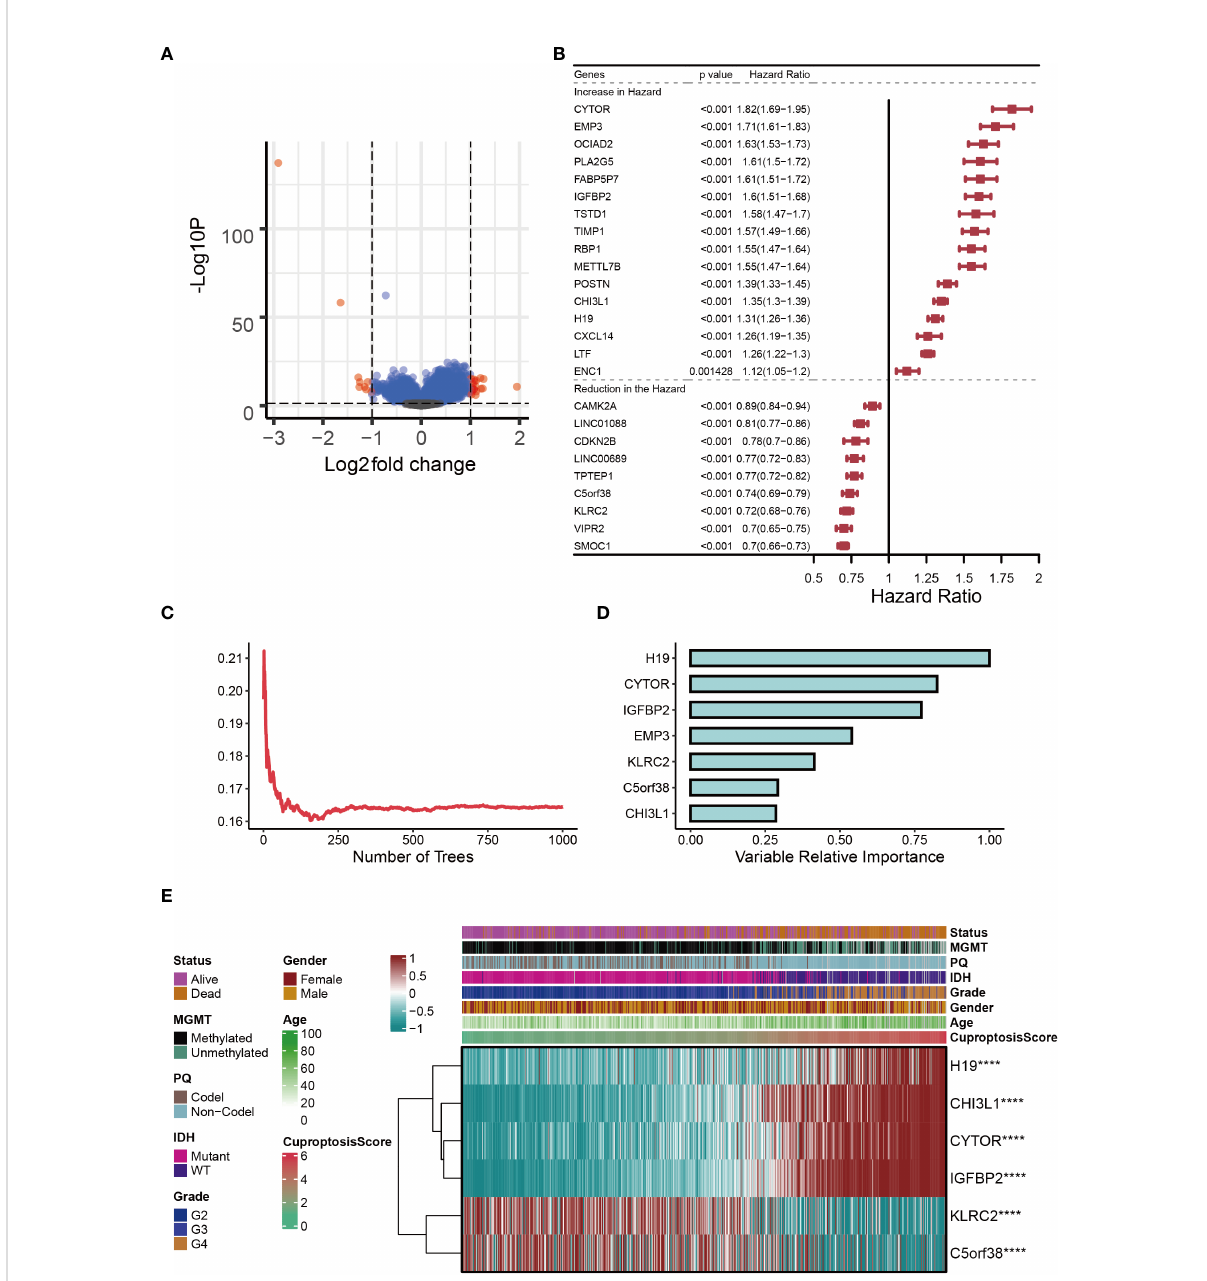
FIGURE 2 Establishment of cuproptosis-signature. (A) The volcano map re fl ects the differentially expressed genes identi fi ed (logFC > 1, P < 0.05). (B) The forest fi gure for Univariate Cox regression analysis of the differentially expressed genes. (C) The distribution of error rates in Random Survival Forest model. (D) The variable relative importance of the seven genes. (E) Heat map showing the relationship between six genes in the cuproptosis-signature and CuproptosisScore distribution and its clinical characteristics. ****P <